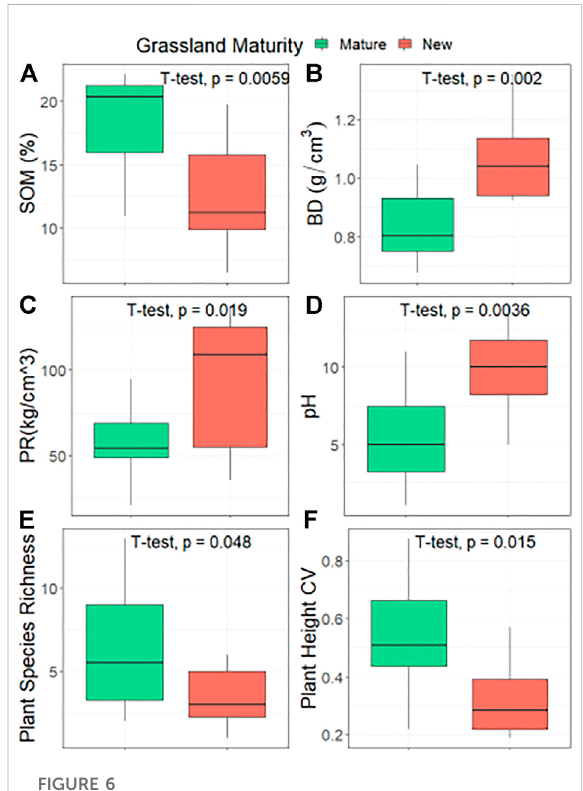
FIGURE 6 Independent T-tests comparing differences in soil properties and vegetation communities between two levels of grassland maturity: mature grasslands (no records of arable cropping between 2005 and 2021) and new grasslands (at least one crop rotation between 2005 and 2022). Labels (A) SOM - soil organic matter; (B) BD – bulk density; (C) PR – penetration resistance; (D) pH; (E) Plant Species Richness; (F) Plant Height CV – coef fi cient of variation in plant